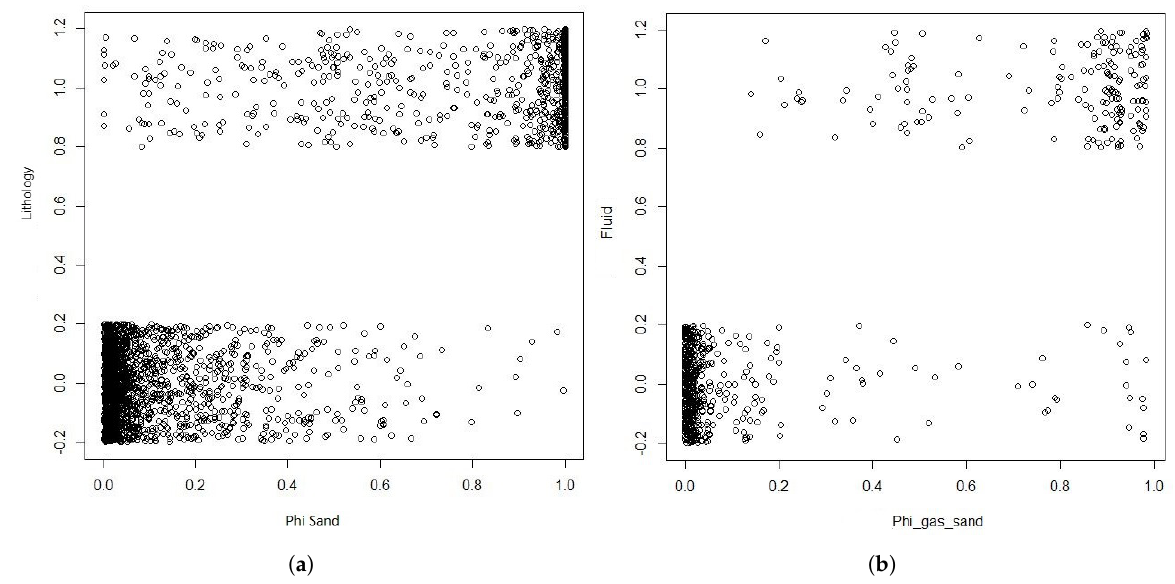
Figure 26. ( a ) Plot of the sand probability (Phi-sand) versus the lithology (facies) variable. ( b ) Plot of the gas probability (Phi-gas-sand) versus the fluid variable.